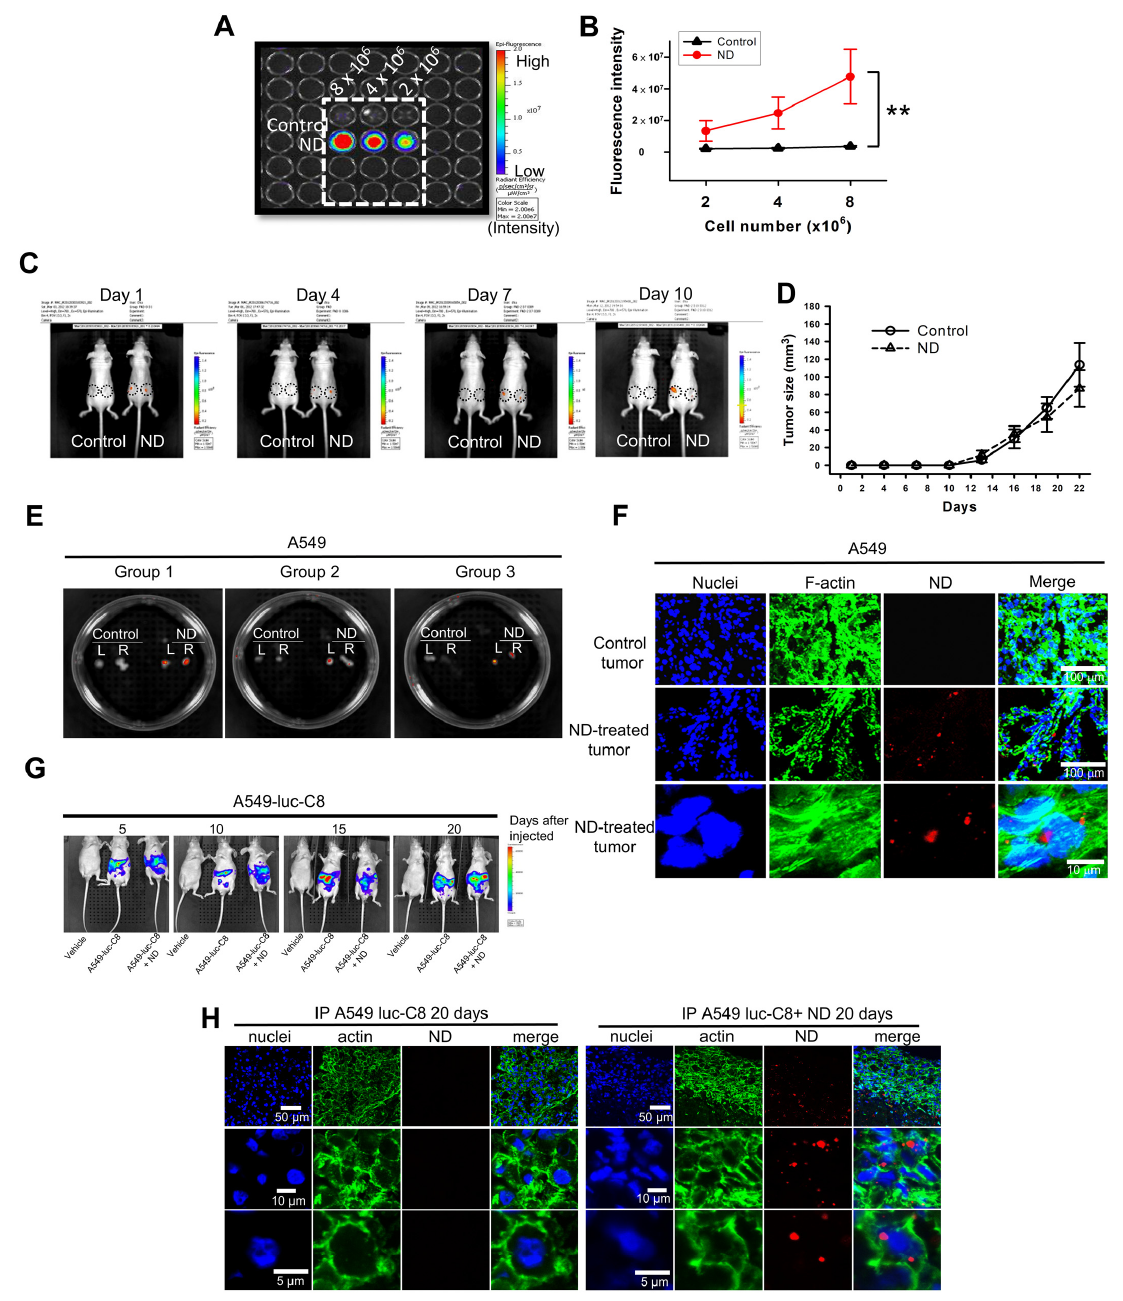
Figure 3. The detection and tumorigenesis of ND-bearing lung cancer cells in vitro and in vivo. ( A ) A549 lung cancer cells were plated at a density of 3 × 10 6 cells per 100 mm Petri dish for 24 h. Then the cells were incubated with 100 nm ND particles (50 µ g/mL for 24 h). At the end of